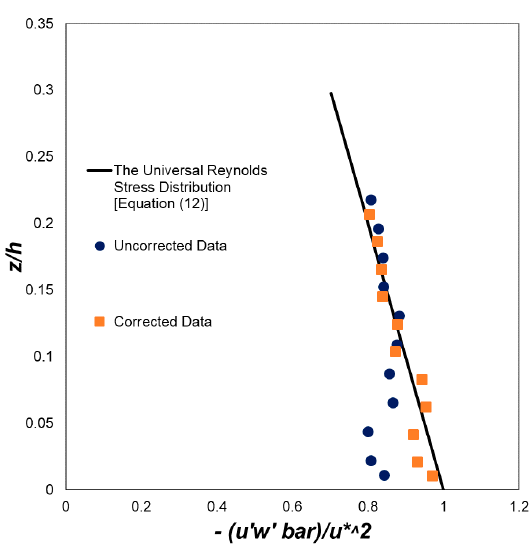
Figure 8. Normalised Reynolds stress over the well-packed laboratory-prepared rough bed.